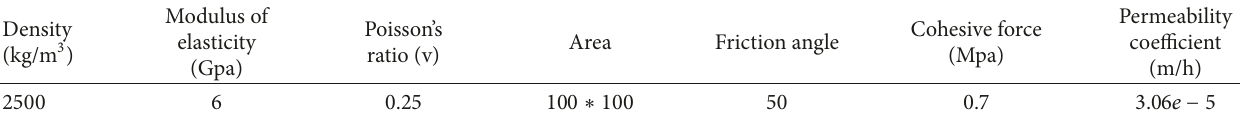
Table 1: Physical and mechanical parameters of the surrounding rock.